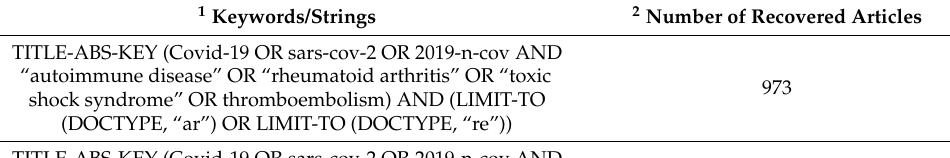
Table 1. Detailed bibliographic search results found in the Scopus